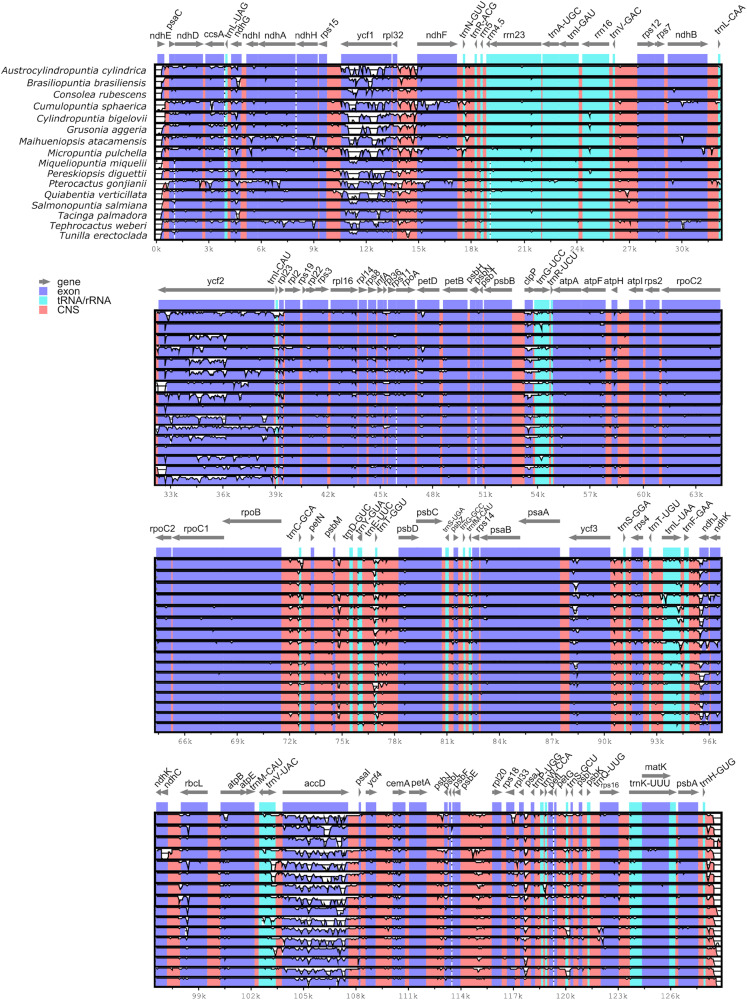
Visualized alignment of the Opuntioideae chloroplast genome sequences (one IR stripped) with annotations using mVISTA. Each horizontal lane shows the graph for the sequence pairwise identity with Opuntia quimilo as reference. The x-axis represents the base sequence of the alignment and the y-axis represents the pairwise percent identity within 50–100%. Gray arrows represent the genes and their orientations. Dark-blue boxes represent exon regions; light-blue boxes represent tRNA and rRNA regions; red boxes represent non-coding sequence (CNS) regions.